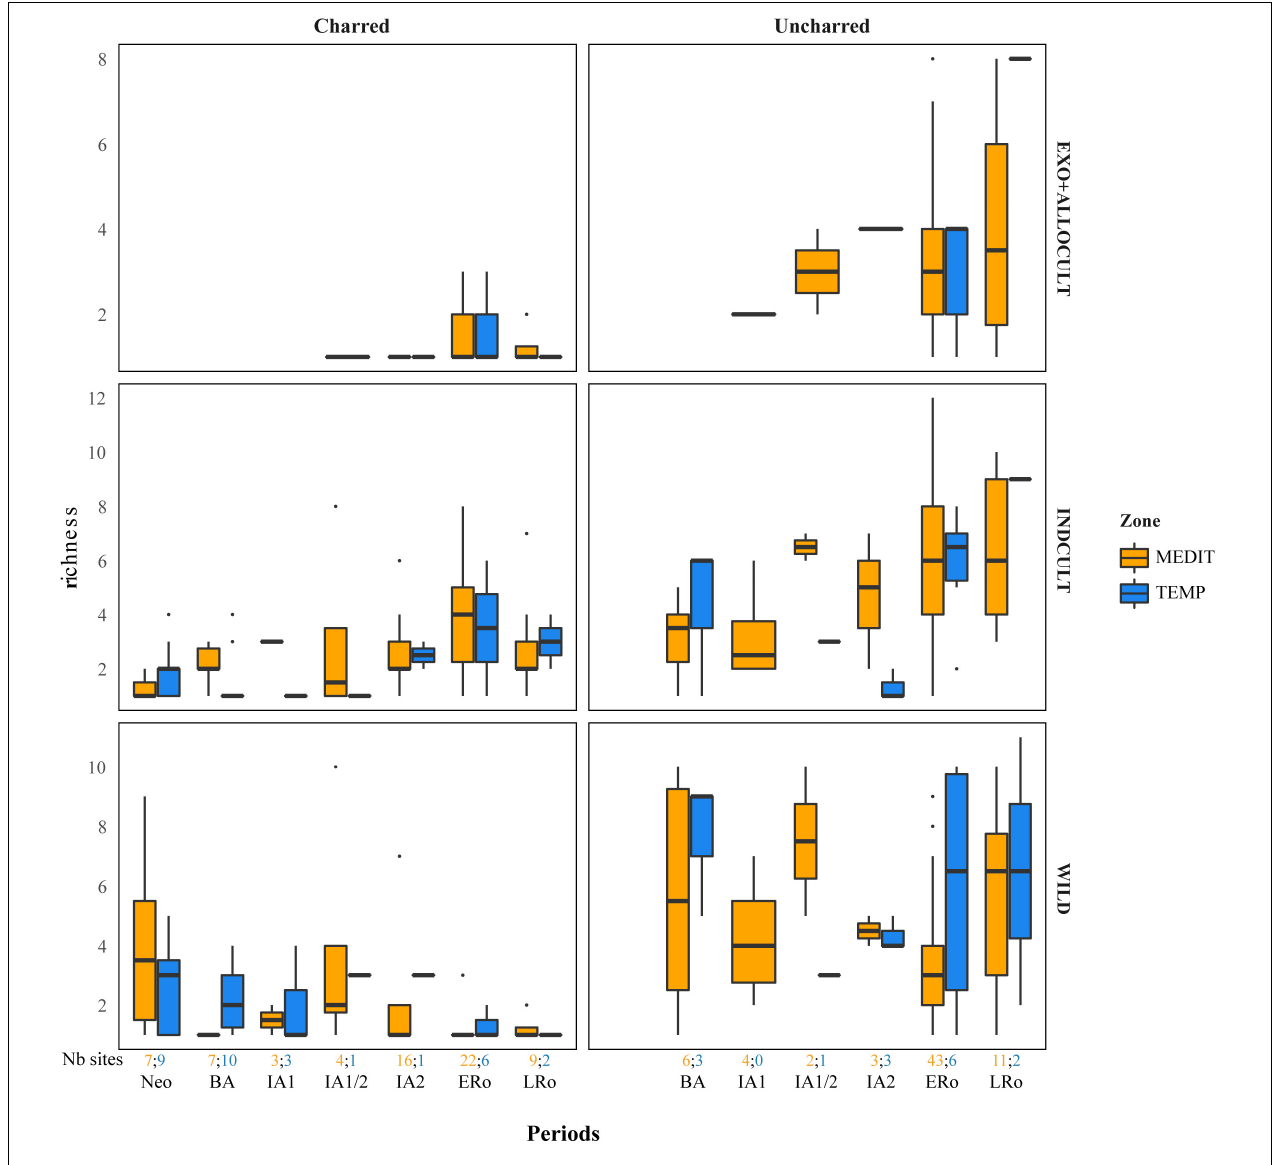
FIGURE 4 | Richness of fruit taxa in the archeological sites in relation to type of preservation, categories of fruit taxa and cultural periods. Richness is calculated as the raw count of fruit taxa in assemblages of at least 25 fruit remains. The number of sites for each period and bioclimatic zone is provided at the bottom of the